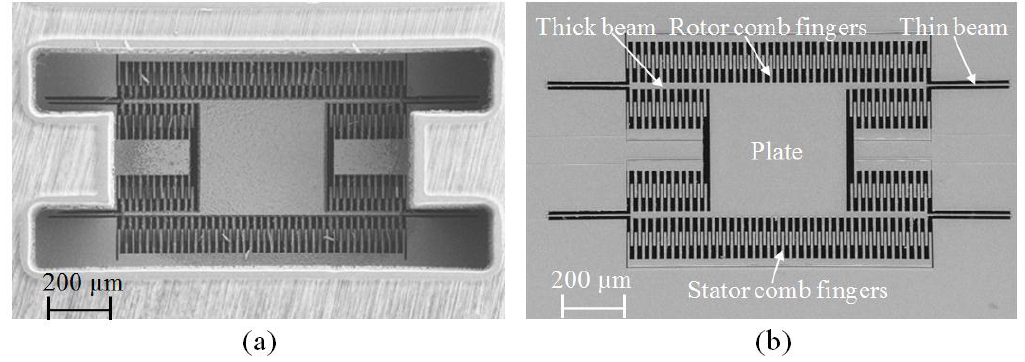
Figure 5. FESEM image of the CMOS-MEMS device from ( a ) Backside; ( b ) Front side